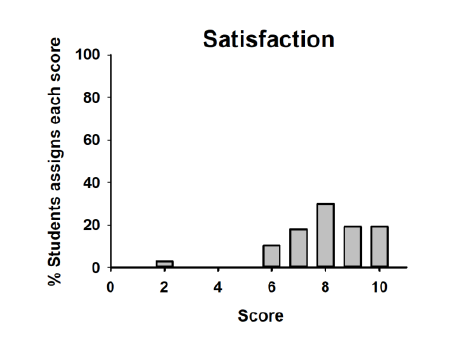
Figure 5. Percentage of students by level of satisfaction with the intervention (score 0: lowest satisfaction, score 10: highest